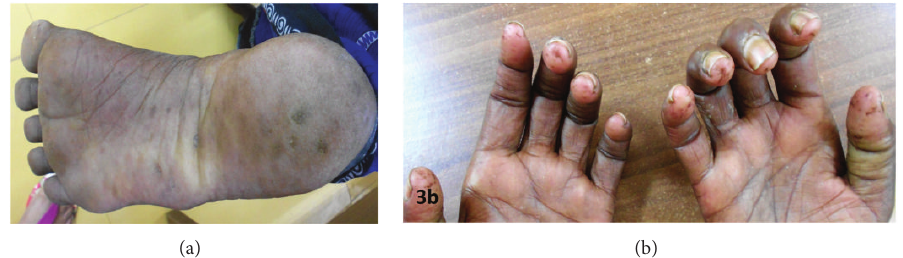
Figure 3: (a) Callus formation and calcinosis on left sole. (b) Digital ulceration and